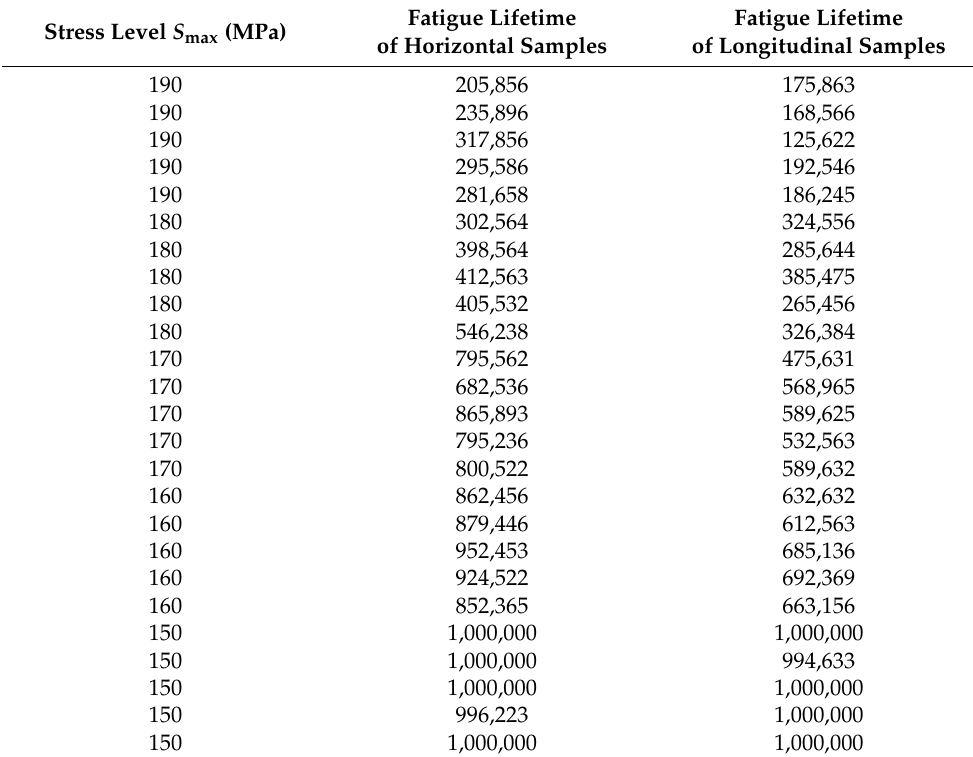
Table 2. Data of horizontal and longitudinal corrosion fatigue test for 2524-T3 aluminum alloy. Fatigue Lifetime Stress Level S max (MPa) of Horizontal